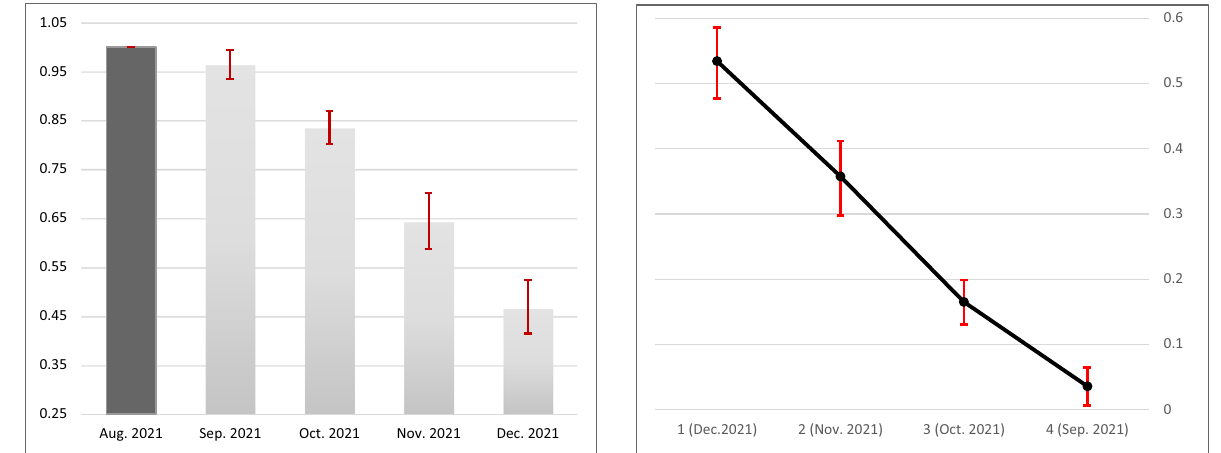
Fig. 2 Adjusted odds ratio (left) and vaccine effectiveness (right) against SARS-CoV-2 breakthrough infection. Left: Data are presented as adjusted OR, as a function of time in months (calendrical month) since the administration of the third dose, with error bars indicating the corresponding 95% Wald ’ s C.I. Right: Data are presented as adjusted VE, as a function of time in months (calendrical month) since the administration of the third dose, with error bars indicating the corresponding 95% Wald ’ s C.I.